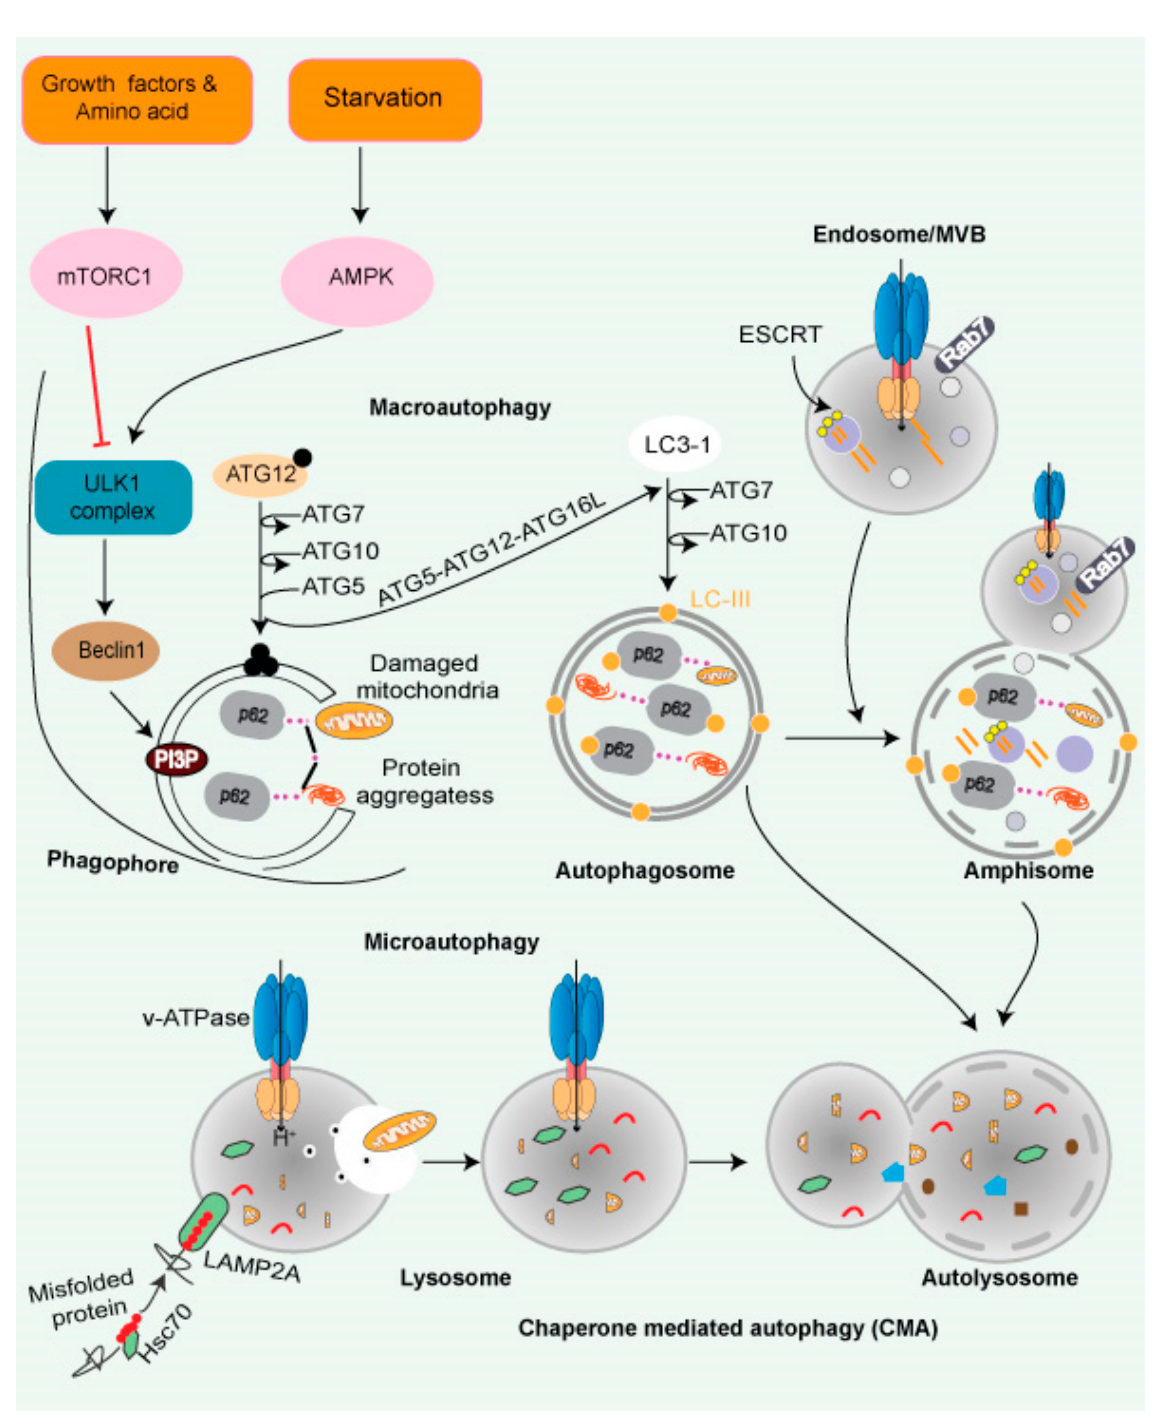
Figure 3. Autophagy and lysosomal pathway. Cytoplasmic cargo is delivered to lysosomes through autophagy. Macroautophagy includes compartmentalizing cytoplasmic payloads in LC3-coated double-membrane vesicles, known as autophagosomes. Structures known as autolysosomes are formed when autophagosomes fuse with lysosomes, and lysosomal hydrolases break down the damaged organelle. The autophagic lysosome reformation process recycles lysosomal components from autolysosomes once cargo breakdown is complete. The recognition of cytoplasmic substrates containing an accessible KFERQ-like motif by HSC70 is vital for chaperone-mediated autophagy. The HSC70-substrate complex is recognized at the lysosomal membrane by LAMP2A. LAMP2A oligomerization then forms a translocation channel, transporting the substrate into the lysosomal lumen. The LAMP2A channel disassembles into monomers after substrate delivery, allowing sub- strate delivery. Microautophagy entails the transport of cargo into the lysosomal lumen via interac- tion. Direct interaction into the endosomal lumen during endosomal microautophagy transport